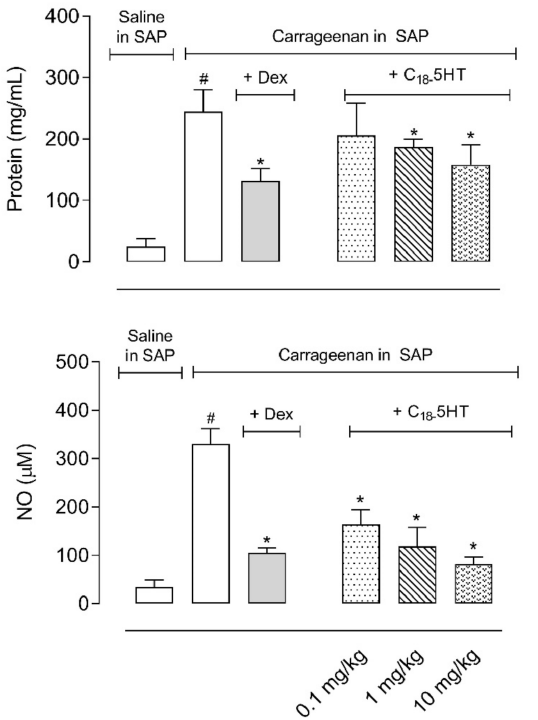
Figure 4. C 18 -5HT reduces protein extravasation and NO production into the subcutaneous air pouch (SAP). The animals were pretreated with vehicle (tween 80, p.o.), C 18 -5HT (0.1, 1, or 10